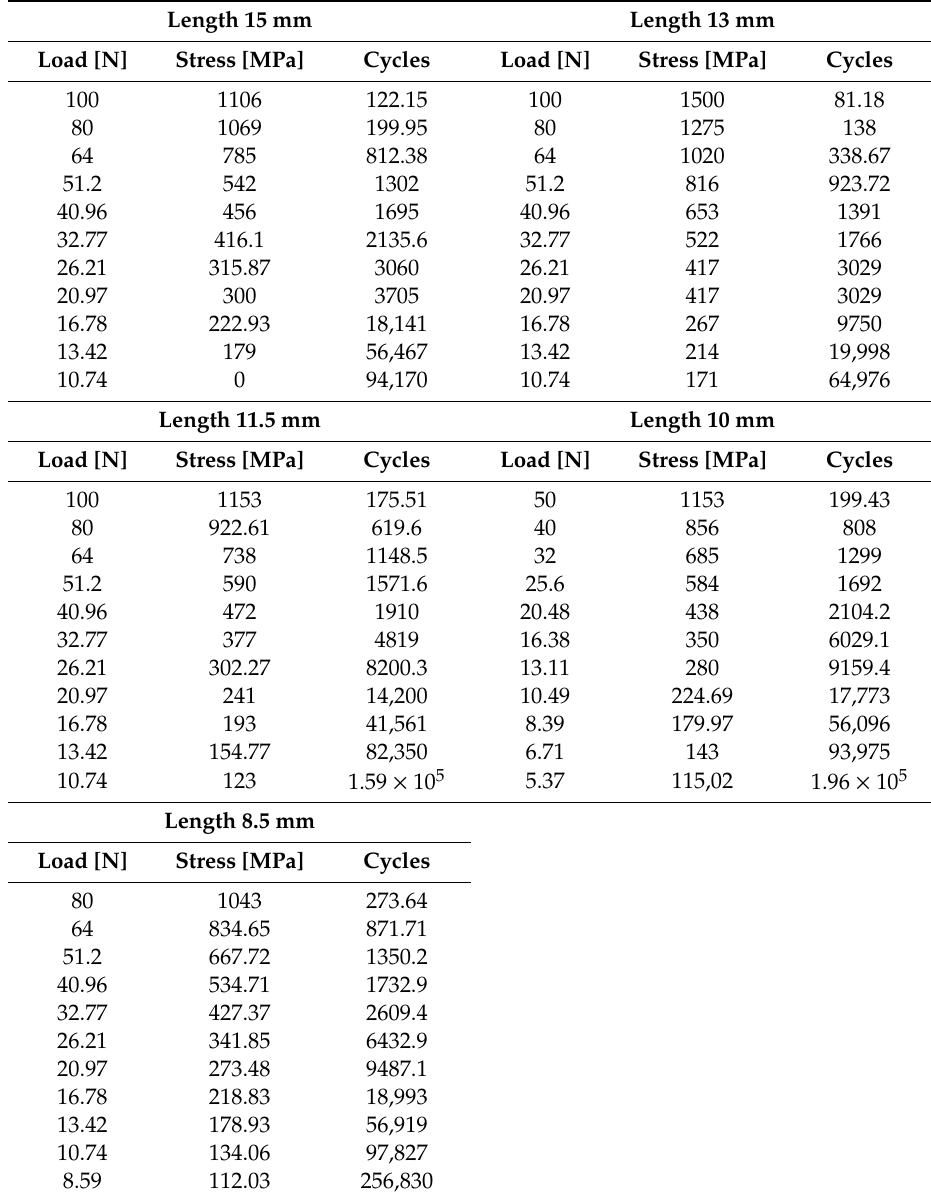
Table 3. Data employed to plot the S–N